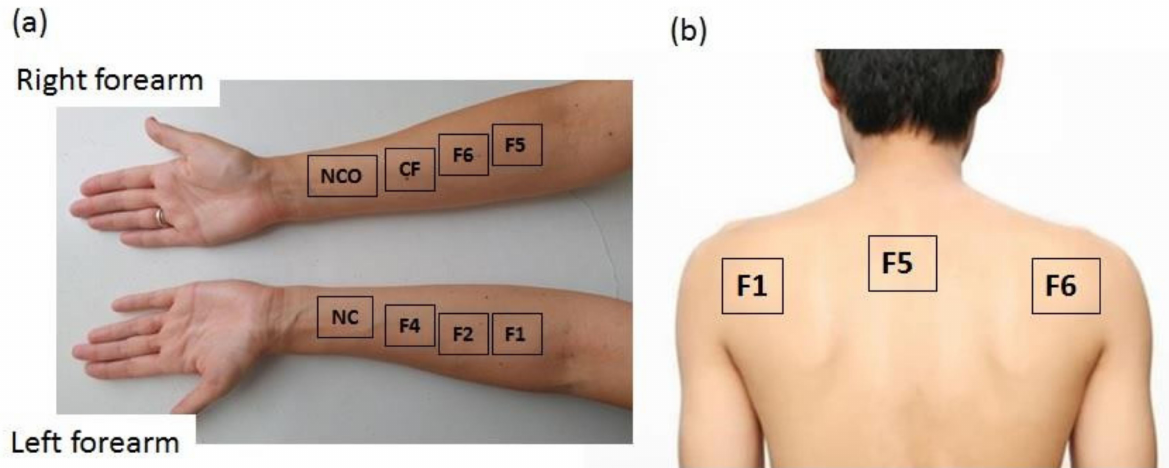
Figure 1. Actual layout of the samples and control sites: non-treated control under occlusion (NCO) and without occlusion (NC) within ( a ) in vivo study under occlusion and ( b ) in vivo substantiv- ity